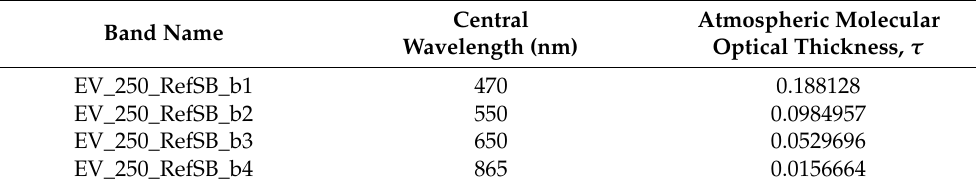
Table 3. The optical thickness of atmospheric molecules based on FY-3D MERSI-II data. Band Name